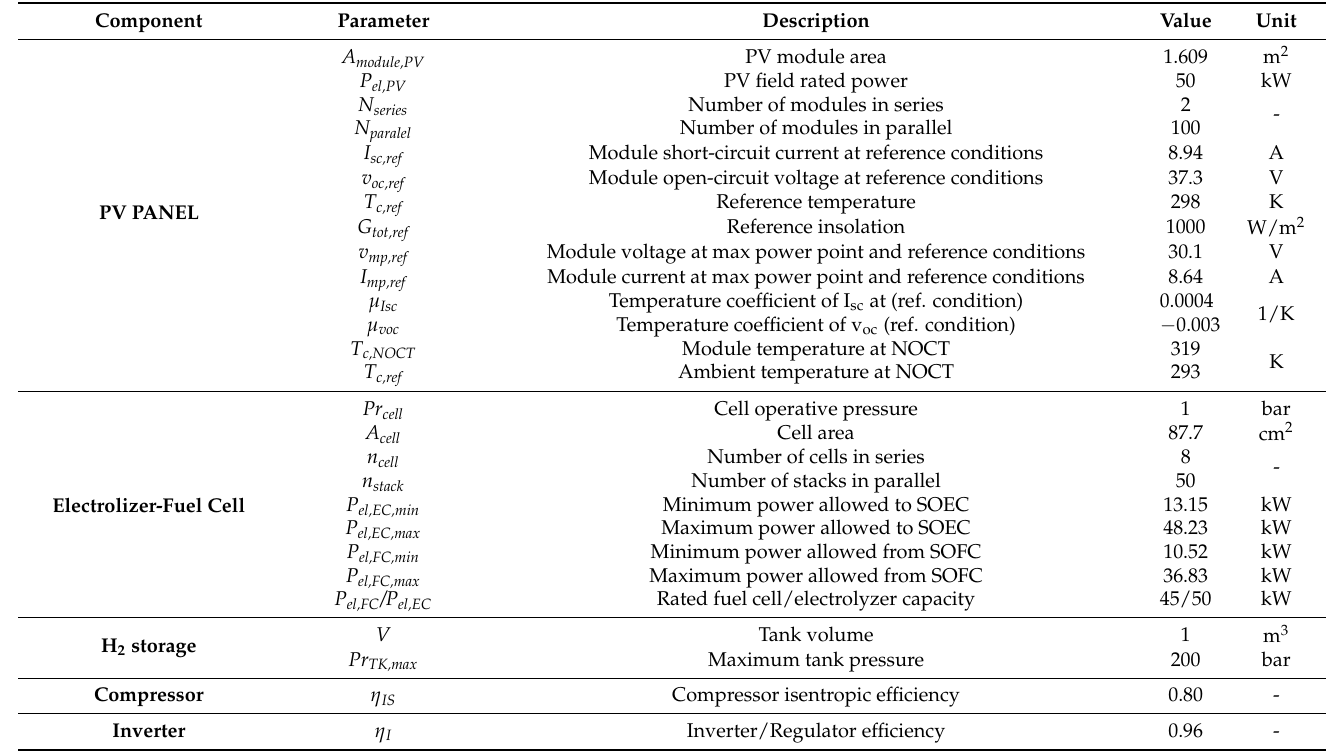
Table 2. System parameters.